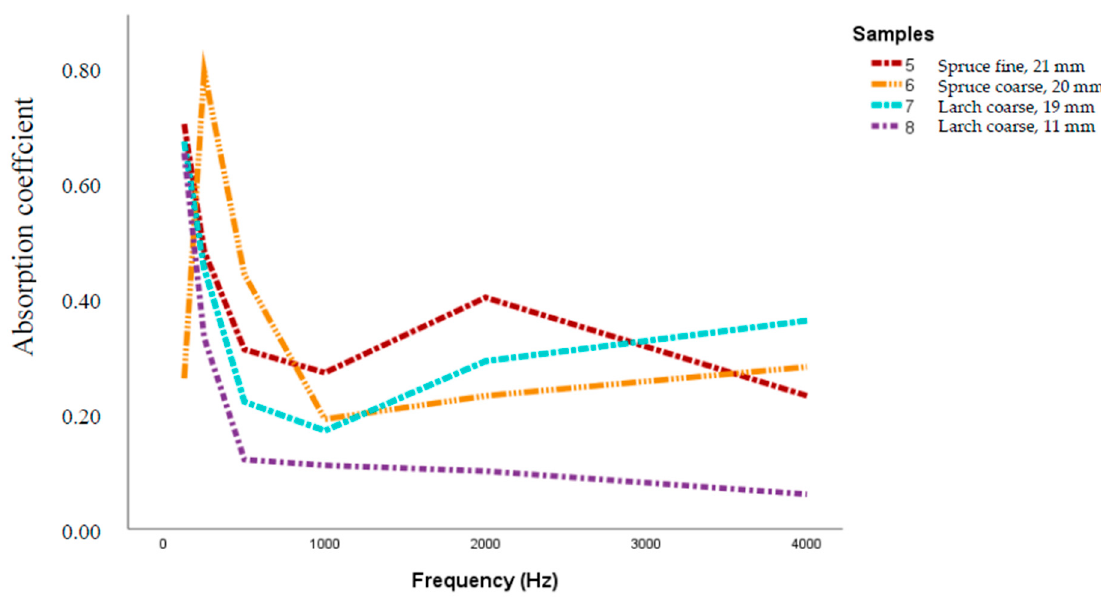
Figure 3. Sound absorption coefficient for spruce and larch bark insulation boards, measured with wall clearance .